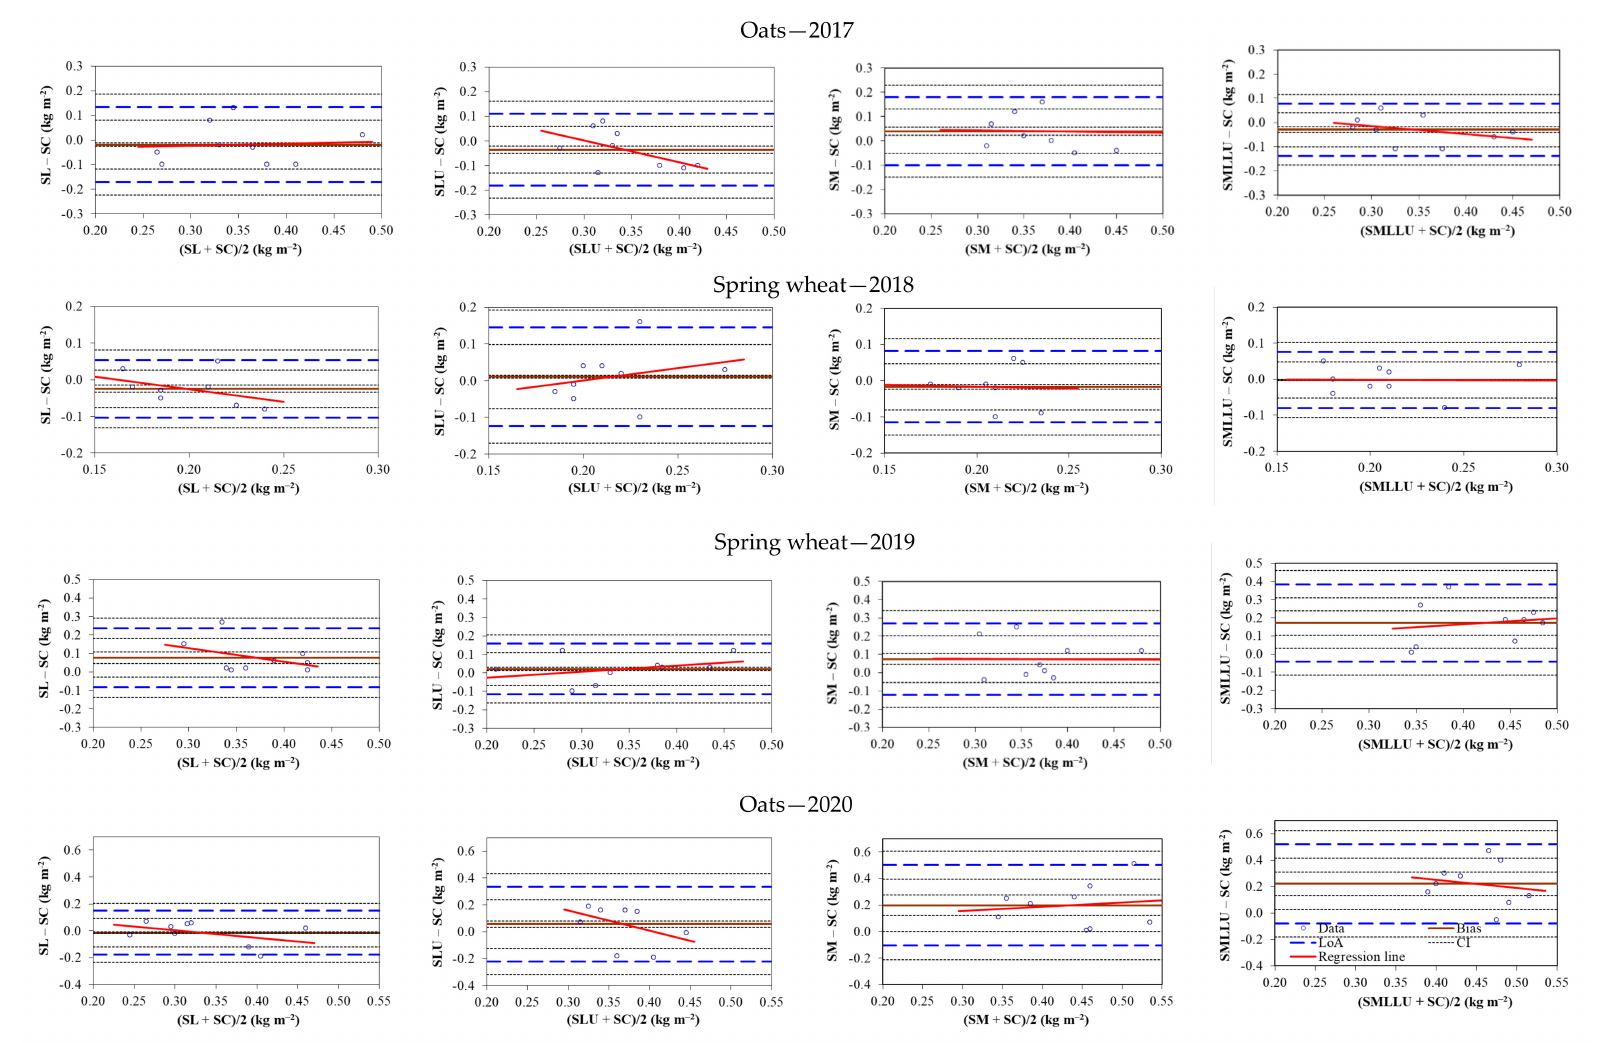
Figure 4. Bland–Altman plots for straw yield (S) (kg m − 2 ) (oats—2017), (spring wheat—2018, 2019), (oats—2020). C—control, L—liming, LU—leguminous catch crops, M—farmyard manure, and MLLU—farmyard manure + liming + leguminous catch crops, LoA—limits of agreement, CI—confidence